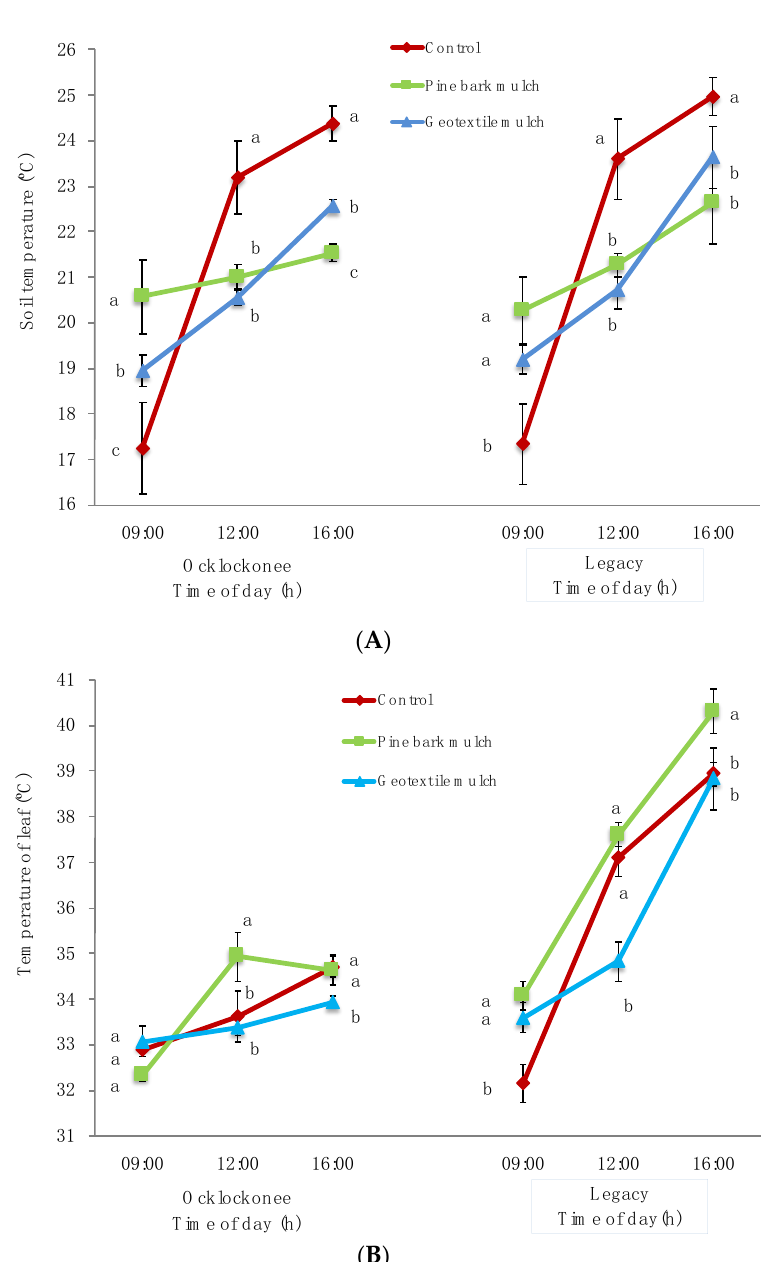
Figure 1. Effects of the different types of mulch: ( A ) soil temperature (°C); ( B ) leaf temperature (°C), at three times of the day. For each different the time of day, lowercase letters indicate significant differences for different types of mulch, according to the Tukey test ( p < 0.05). The vertical bars correspond to ± the standard error of the mean ( n = 9).